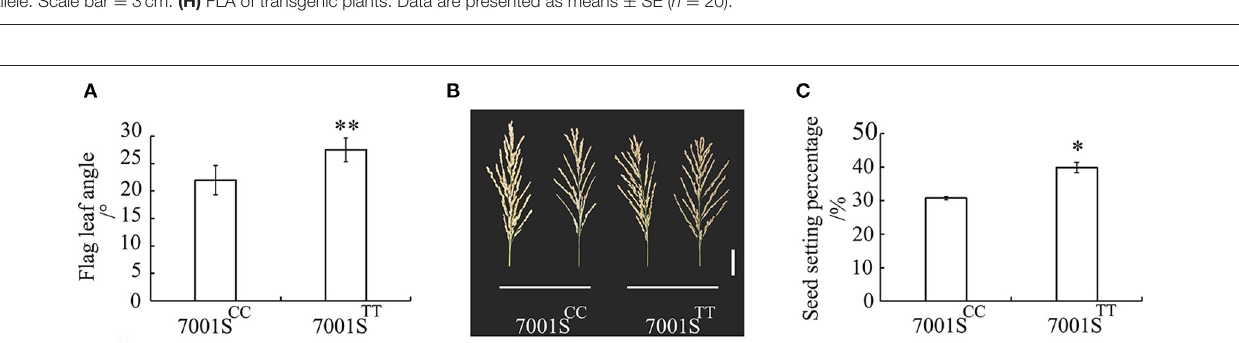
FIGURE 4 | variation in Os02g0142875 . The candidate region lies between the red solid lines. (C) Haplotypes of OsFLA2 associated with flag leaf angle in rice. (D,E) Box plots of flag leaf angle in accessions containing the different haplotypes (D) and elite alleles (E) . Center line, median; box limits, upper and lower quartiles; whiskers, 1.5 × the interquartile range; dots, outliers. Differences between the alleles were statistically analyzed based on Welch’s t -test. (F) Relative expression of Os02g0142875 in flag leaf and flag leaf lamina joint at development stages 6–8 from the three accessions (i.e., Ludao, Haomake, and A7444) with a large FLA and the three accessions (i.e., Nipponbare, Kendao 13, and Chenwan 3hao) with a small FLA, determined by qRT-PCR (** P < 0.01, two-tailed Welch’s t -test). Data are presented as means ± SE; n = 3 independent biological replicates. (G) Images of FLA of transgenic plants transformed with the empty vector (VEC), C allele, and T allele. Scale bar = 3cm. (H) FLA of transgenic plants. Data are presented as means ± SE ( n = 20).